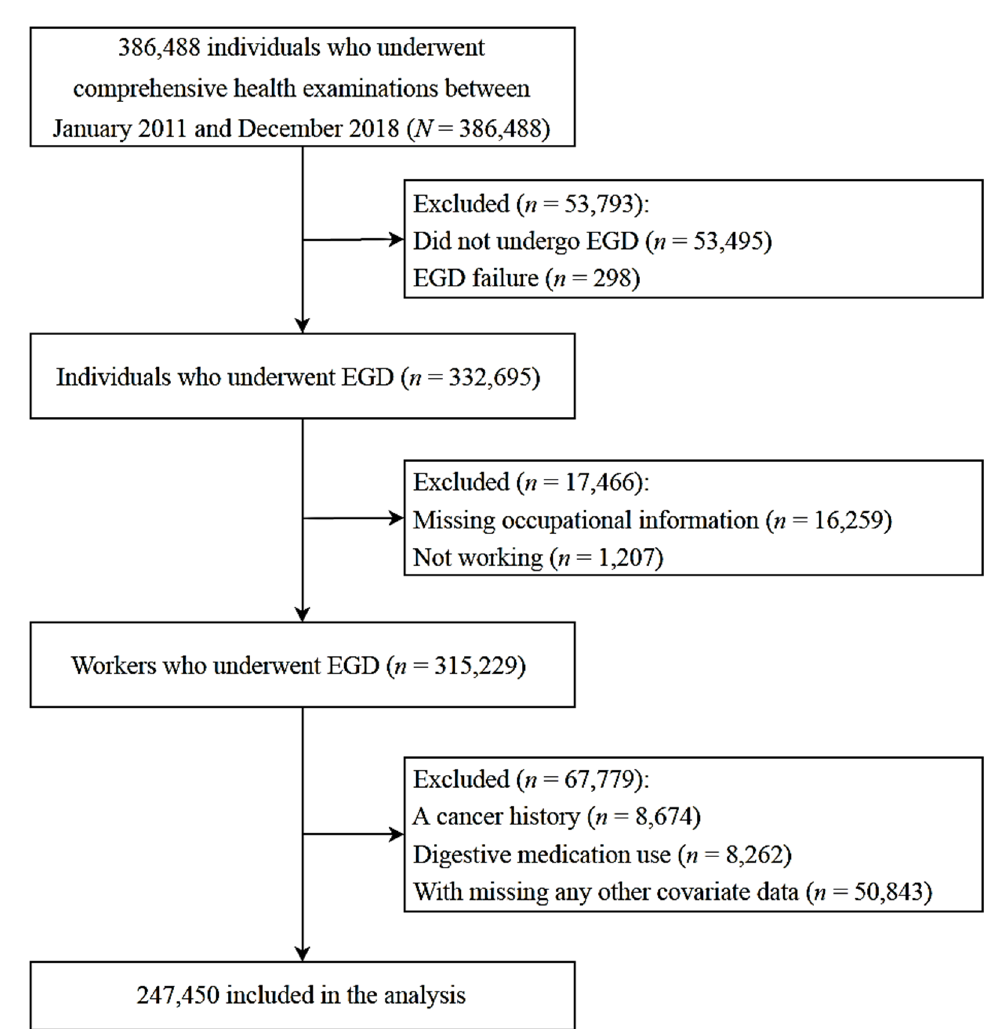
Figure 1. Participant selection flowchart. EGD: esophagogastroduodenoscopy.